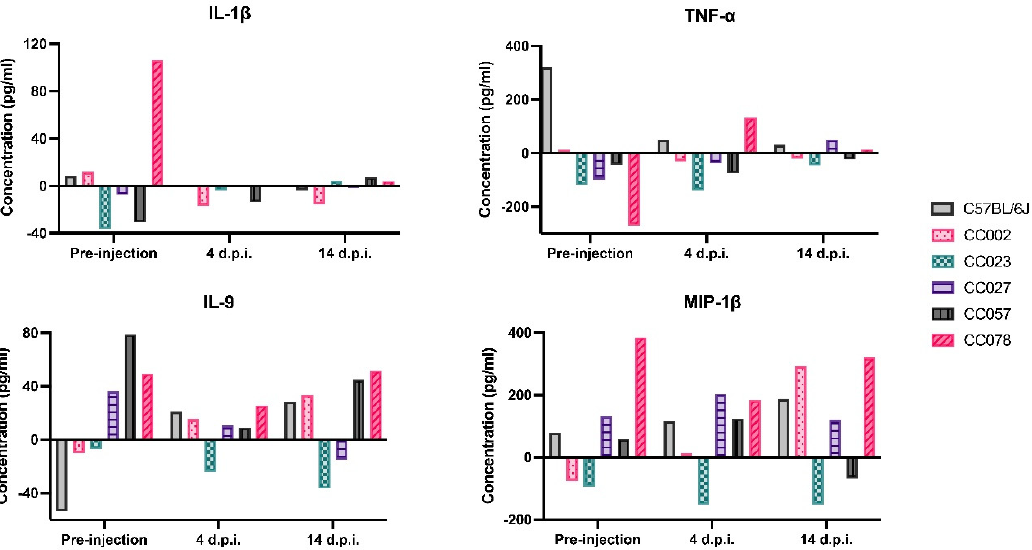
Figure 5. Strain-specific temporal changes in phenotype-associated cytokines and chemokines. To reflect average strain-specific differences produced throughout the acute phase, we subtracted average control levels from average infected levels respective to the observed time point. The y-axes demonstrate the differences among concentration levels for the selected cytokines and chemokines. Levels below the x-axis demonstrate that PBS-injected mice produced these cytokines at higher levels than TMEV-infected mice at that specific time point. Levels above the x-axis illustrate that TMEV-infected mice produced these responses at higher levels than PBS-injected mice. These cytokines and chemokines can be used as potential serum biomarkers for the different TMEV-induced phenotypes observed throughout the first 14 days of